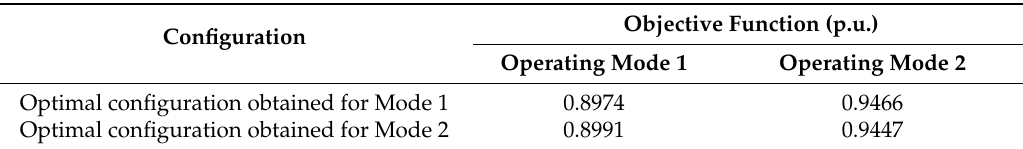
Table 5. Objective function of the optimal